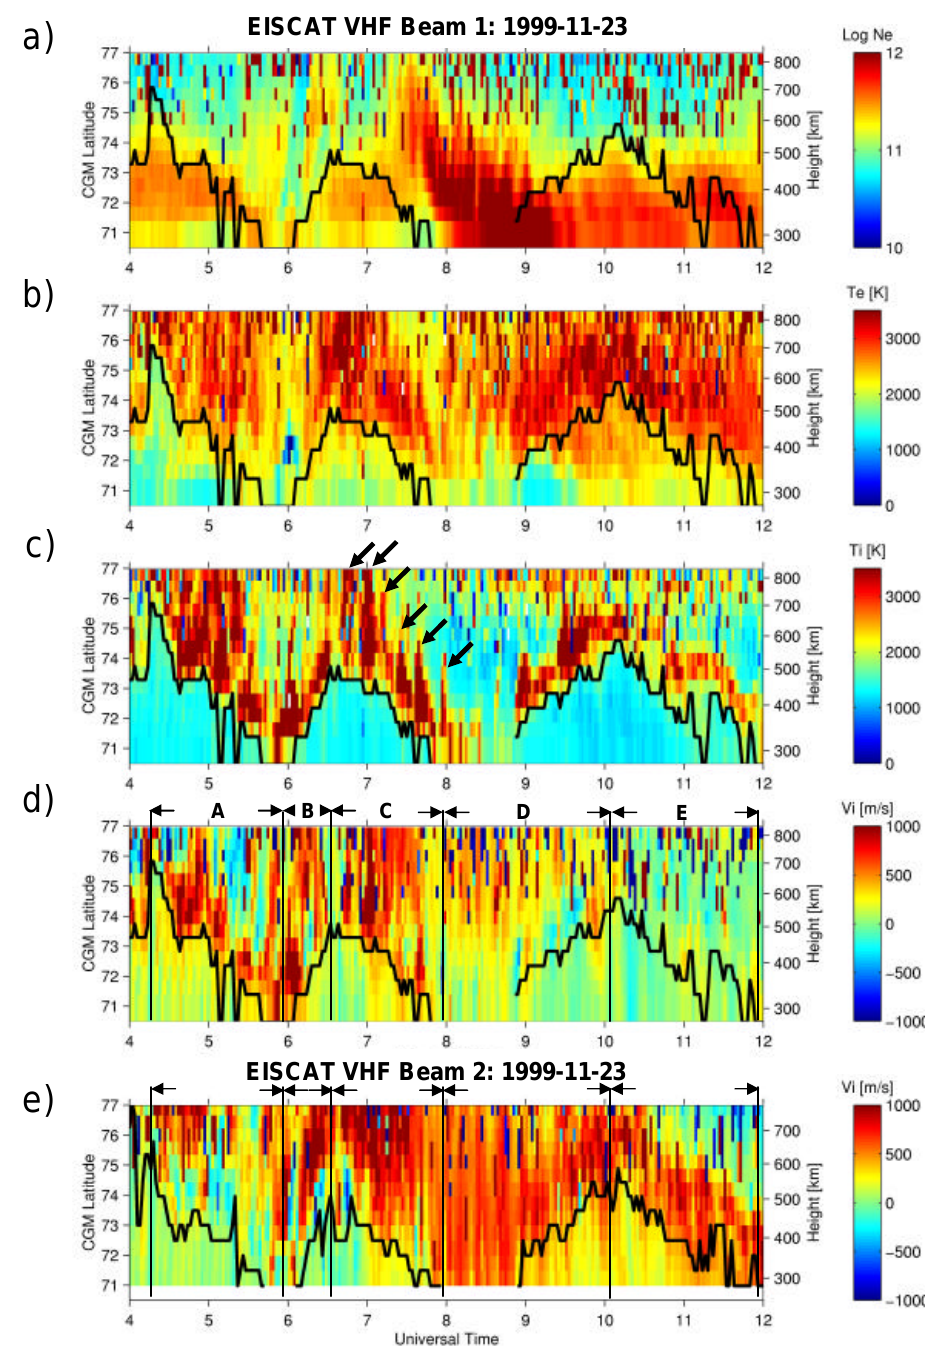
Fig. 2. Plasma parameter plots obtained by EISCAT VHF in a V-shape configuration above Svalbard at 30 ◦ elevation. Panels (a)–(d) show the electron density, electron temperature, ion temperature and line-of-sight ion velocity for the boresite Beam 1 pointing 15 ◦ east of geographic north. The bottom panel (e) shows the line-of-sight ion velocity for the phase-shifted beam pointing towards geographic north. Positive velocity means away from the radar